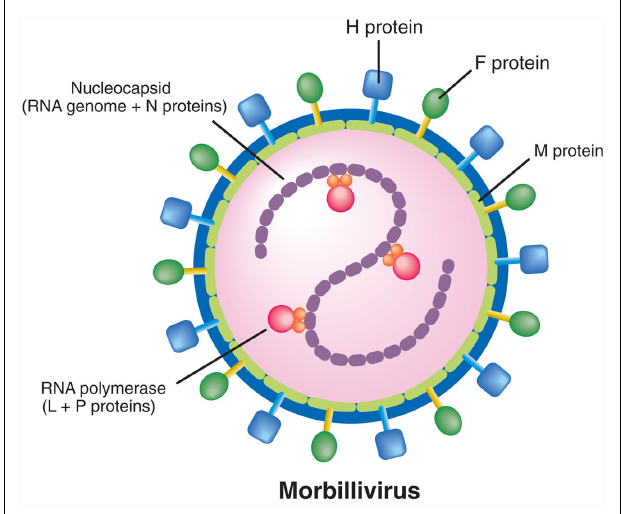
FIGURE 1 | Schematic diagram of the components of the morbillivirus. The viral particle contains the ribonucleoprotein complex consisting of the nucleocapsid (genomic RNA and N proteins) and viral RNA polymerase (P and L proteins), and the envelope consisting of the M, F, H proteins, and host cell-derived